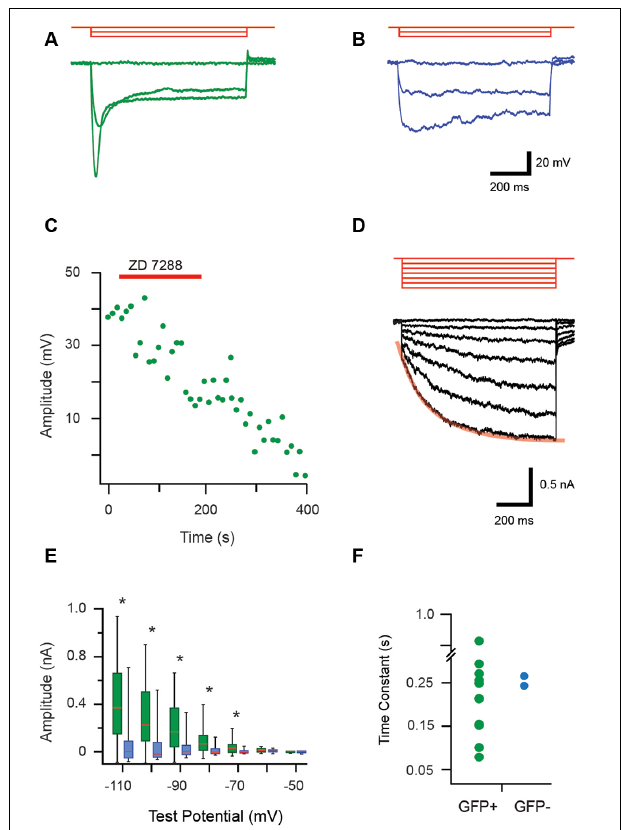
FIGURE 4 | Properties of hyperpolarization-activated currents (I h ) in proprioceptive DRG cells. (A,B) Overlaid traces showing current-clamp recordings from isolated GFP+ and GFP − DRG neurons during hyperpolarizing current injection (3 steps, 100 pA increments, 1 s